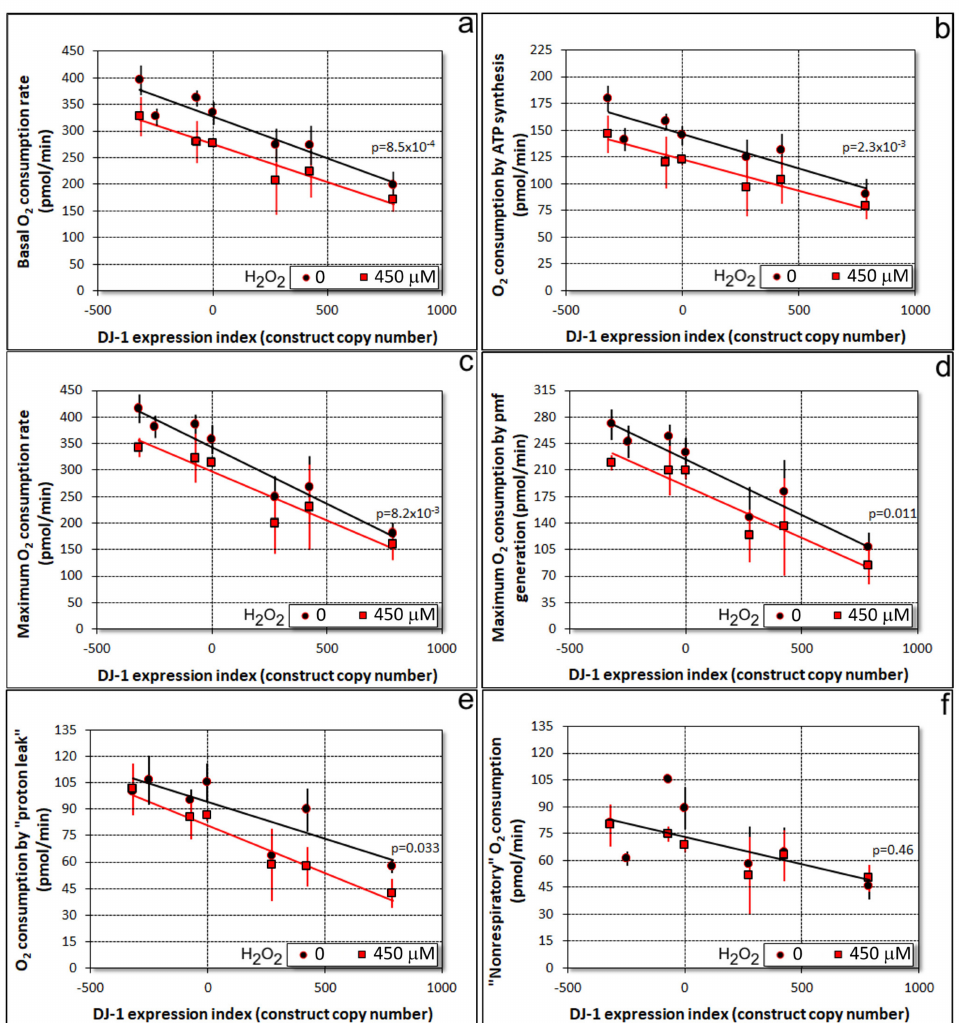
Figure 1. Mitochondrial respiratory activity is inhibited separately by oxidative stress and DJ-1. O 2 consumption rates (OCR) in respiration were measured for 1 × 10 5 cells per well in a Seahorse XFe 24 Extracellular Flux Analyzer. An explanatory example trace is shown in Supplementary Figure S1. After measurement of basal respiration ( a ), the OCR was then measured after successive additions of ATP synthase inhibitor oligomycin (the resulting decrease representing OCR by ATP synthesis ( b )), the proton ionophore CCCP (to uncouple respiration, allowing maximum O 2 consumption ( c )), the Complex I inhibitor rotenone and either the Complex III inhibitor antimycin A or the Alternative Oxidase inhibitor BHAM (the sum of the decreases caused by these latter 3 inhibitors representing the maximum pmf-generating OCR ie. OCR by proton pumping ( d )). The “nonrespiratory” OCR ( f ) was calculated as the maximum OCR minus the pmf-generating OCR) and the OCR by the “proton leak” ( e ) was calculated as the difference between the OCR after oligomycin addition and the “nonrespiratory” OCR. Multiple regression analysis was conducted to assess the significance of effects of oxidative stress (exposure to 450 µ M H 2 O 2 ) and altered DJ-1 expression levels. The DJ-1 expression index for each individual transformant was determined using qPCR and expressed using the previously established convention of assigning negative copy numbers to the antisense inhibition (knockdown) and positive numbers to the overexpression constructs [18]. The constructs are inserted stably at one or a few random sites in the Dictyostelium genome where they are tandemly replicated during the integration process [42]. The insertion sites and copy numbers differ in each individual transformant. Each point represents a single, independent transformant strain assayed in 4 separate wells (technical replicates) per experiment and averaged over 3 independent experiments. All electron transport-driven components of respiration were inhibited to a proportionately similar extent, both by DJ-1 and by oxidative stress. The significance probabilities shown represent the probability that the intercepts of the regression lines are the same, with and without oxidative stress. They, therefore, represent the statistical significance of the inhibition of mitochondrial function by H 2 O 2 . Error bars are standard errors of the